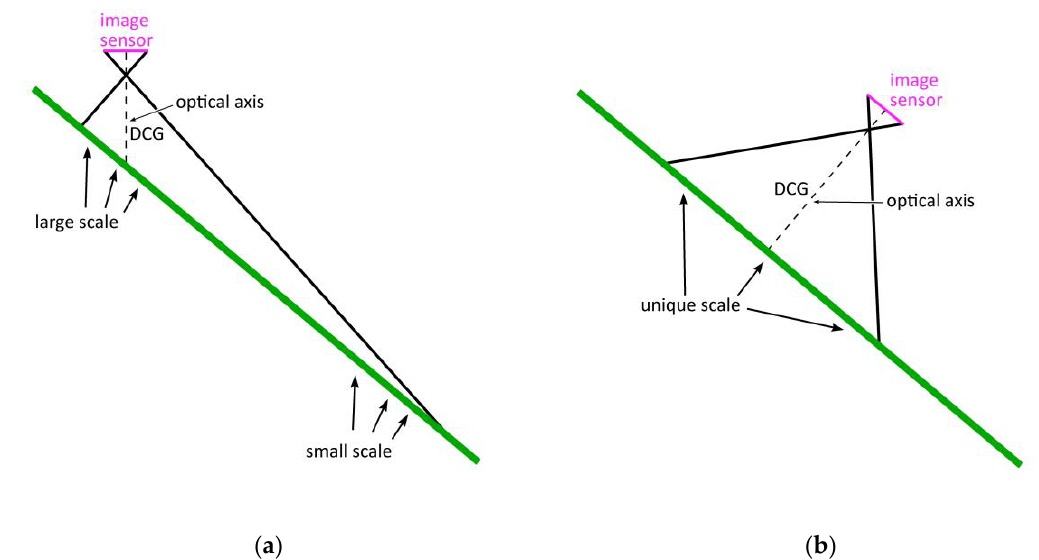
Figure 2 . Photographing steep terrain with a ( a ) vertical image and an ( b ) oblique image. Figure 2. Photographing steep terrain with a ( a ) vertical image and an ( b ) oblique